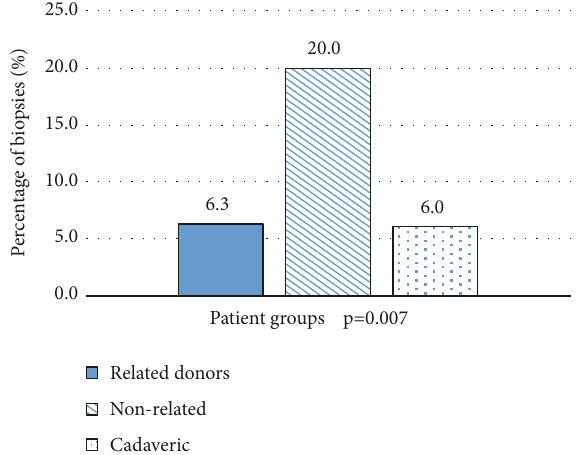
Figure 5: The proportion of HLA-DR antigen mismatches in